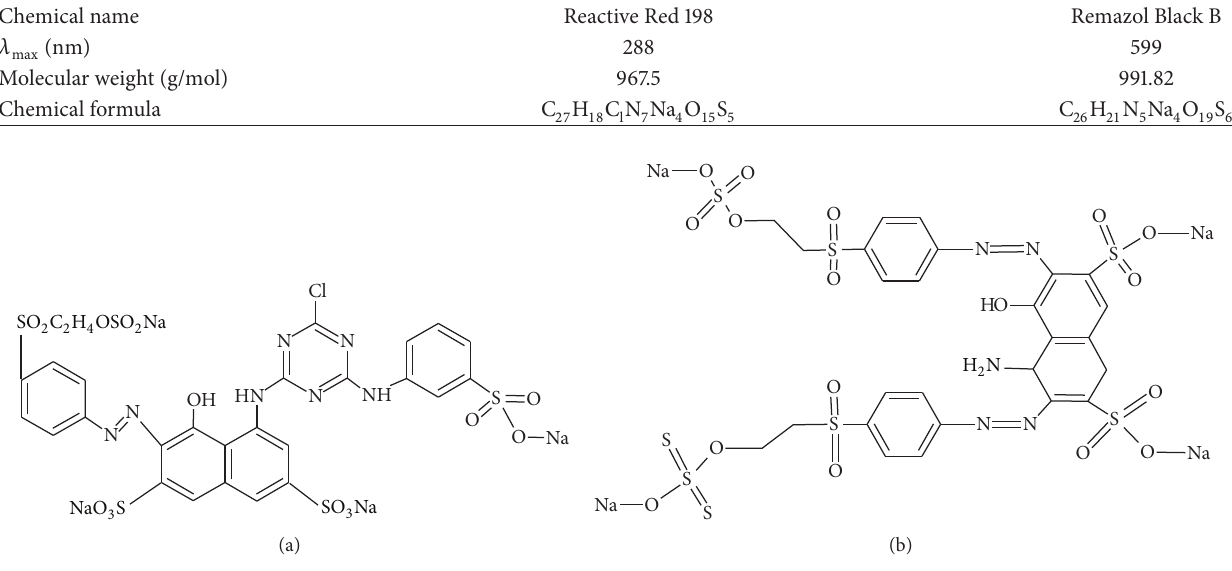
Figure 1: Molecular structure of (a) Reactive Red-RB and (b) Reactive